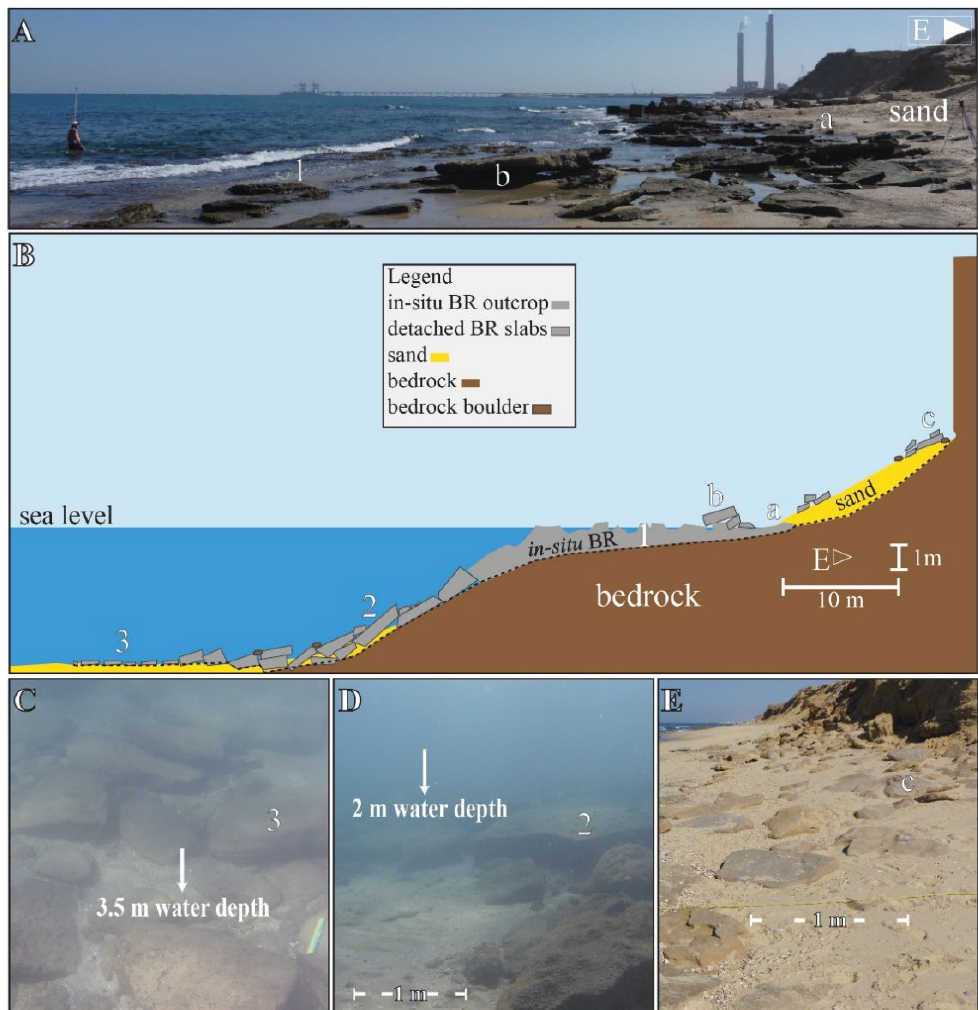
Figure 3. Beachrock outcrop south of Tel Ashkelon: ( A ) view of the site ( 1 : in-situ BR outcrop, ( a ) BR: unconsolidated sediment contact, ( b ) clast of BR slabs; ( B ) schematic cross-section of the outcrop (VE = 4, 2 : submerged BR slab apron (see ( D )), 3 : clast of BR plates (see ( C )), ( c ) clast of BR plates backshore (see ( E )), dotted line marks uncertain depth of unit contact depth, other notes are as in ( A ); ( C ) submerged clast of BR plates at the sea side edge of the outcrop (scale at bottom right is 0.3 m); ( D ) submerged BR slab apron (looking north); ( E ) beachrock plates at backshore (looking